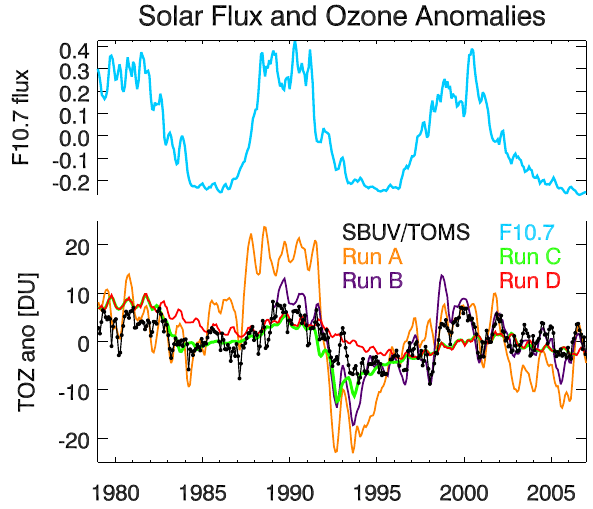
Fig. 1. Comparison of monthly tropical (25 ◦ S–25 ◦ N) total ozone anomalies inDU (lower panel) from the v5 SBUV/TOMS merged ozone data set (black line) with results from SLIMCAT runs A E40 (orange line), B EI (violet line), C FIX (green line) and D AFIX (red line). The normalised F10.7cm solar flux used in the analysis are shown in upper panel (light blue